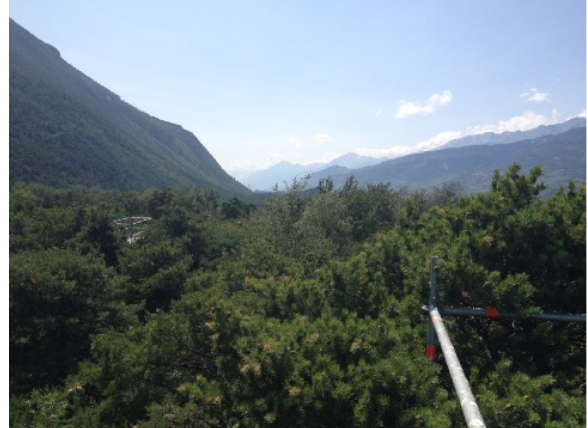
Figure 4. Orthophoto of test site "WSL Garten" (24MP RGB- camera).